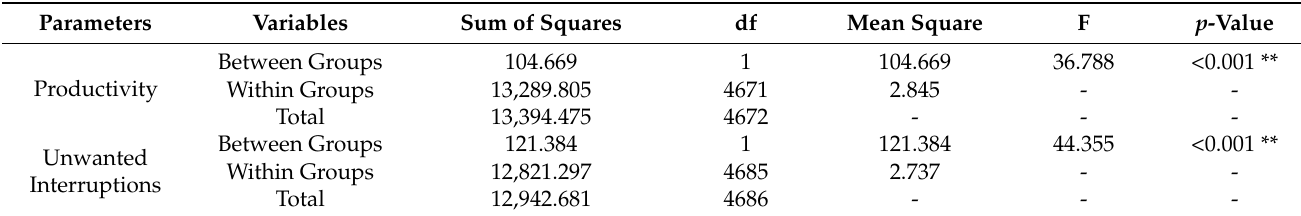
Table 11. One ‐ way ANOVA analysis comparing perceived productivity and unwanted interruptions for under 30 years and 30 years or over.